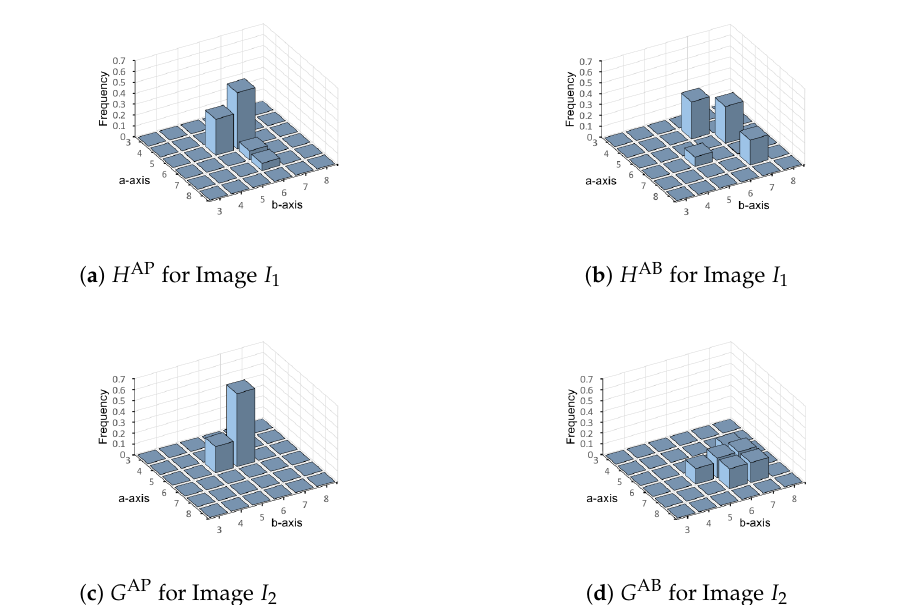
Figure 4. Example of apparent and absent color